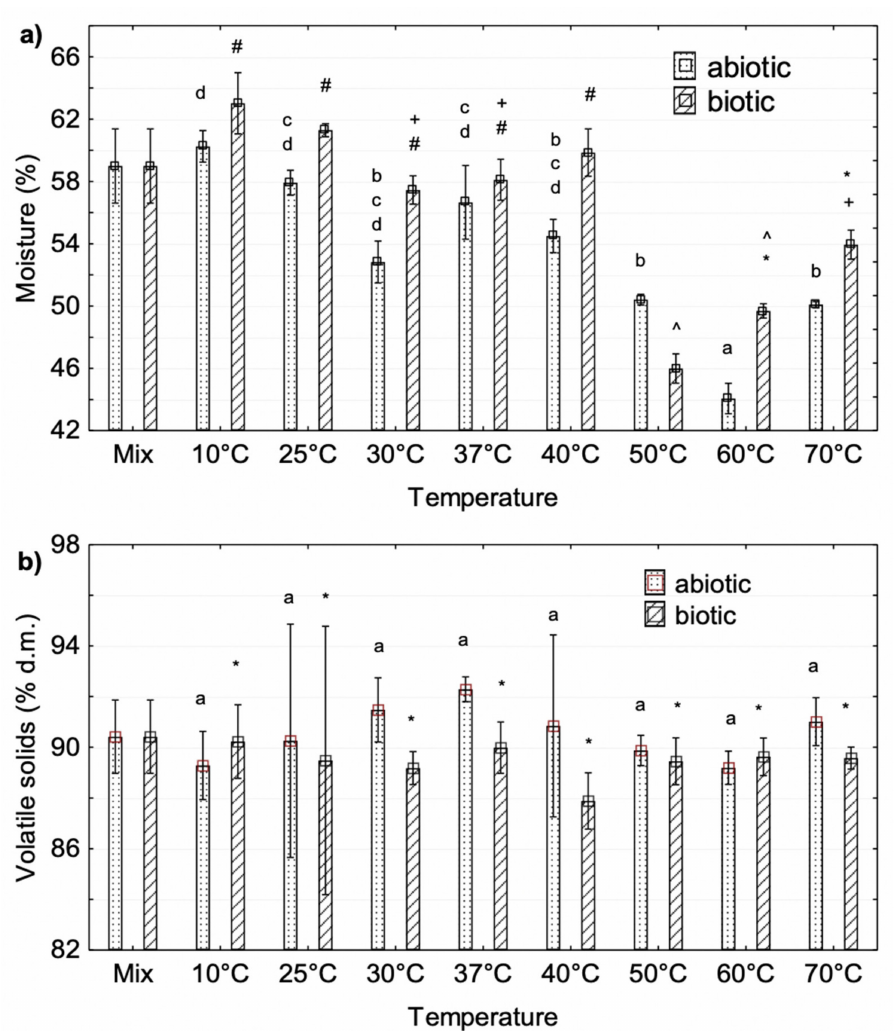
Figure 2. ( a ) Moisture content in biowaste (Mix—before the experiment) and residual biowaste after biowaste aerobic biostabilization under biotic and abiotic conditions under di ff erent thermal conditions,( b ) volatile solids content in biowaste (Mix—before the experiment); letters and symbols (a, b, c, d, *, + , #) indicate homogeneity group according to Tukey’stest at significance level p < 0.05 (abiotic and biotic variant, respectively). The error bars are showing +/ − standard deviation around the